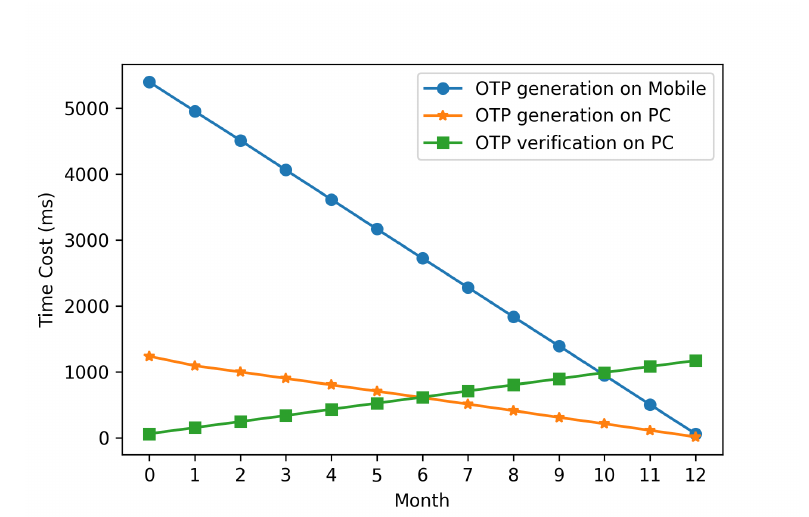
Figure 11. OTP generation and verification time cost of T/Key (valid for one year).